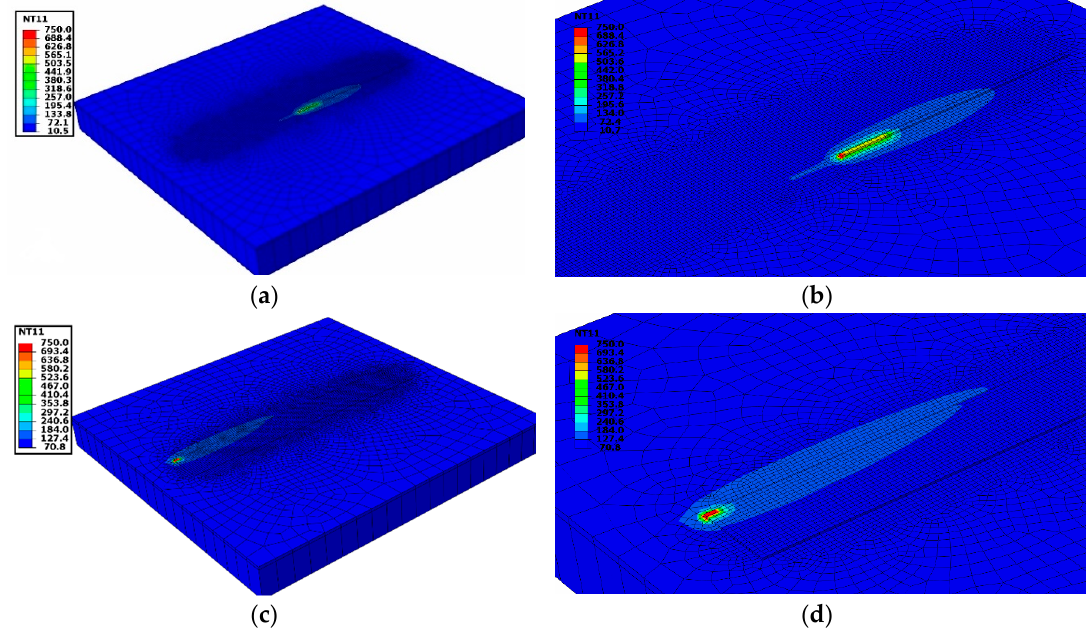
Figure 10. ( a ) Temperature profile during 1st track deposition; ( b ) Detail view of 1st track deposition; ( c ) Temperature profile during 19th track deposition; ( d ) Detailed view at the end of the deposition.